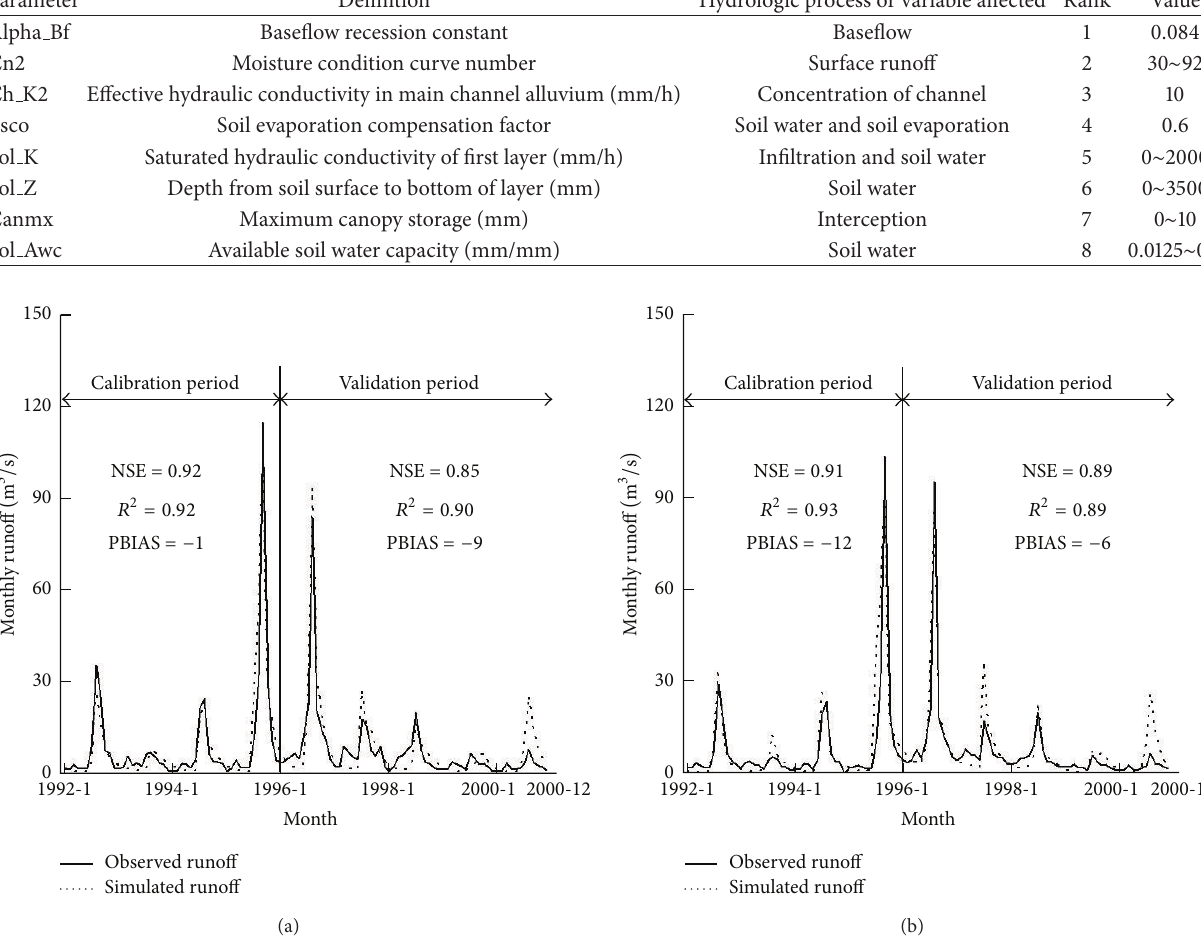
runoff. This study did not take into account impounding of overestimation of the actual runoff in